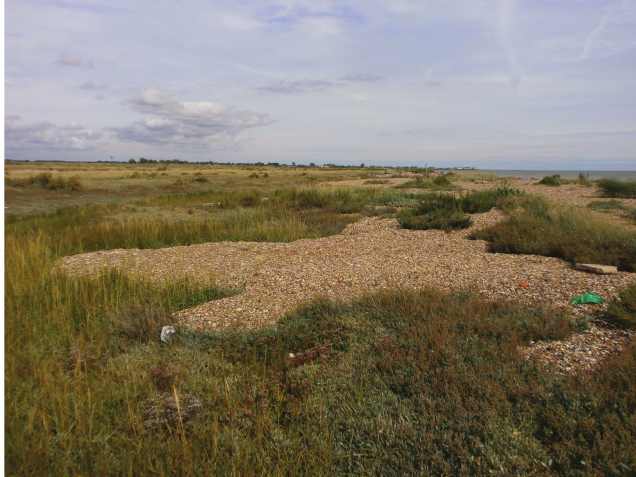
Fig. 2. Shingle deposition on the back dunes. Photo credit Tim